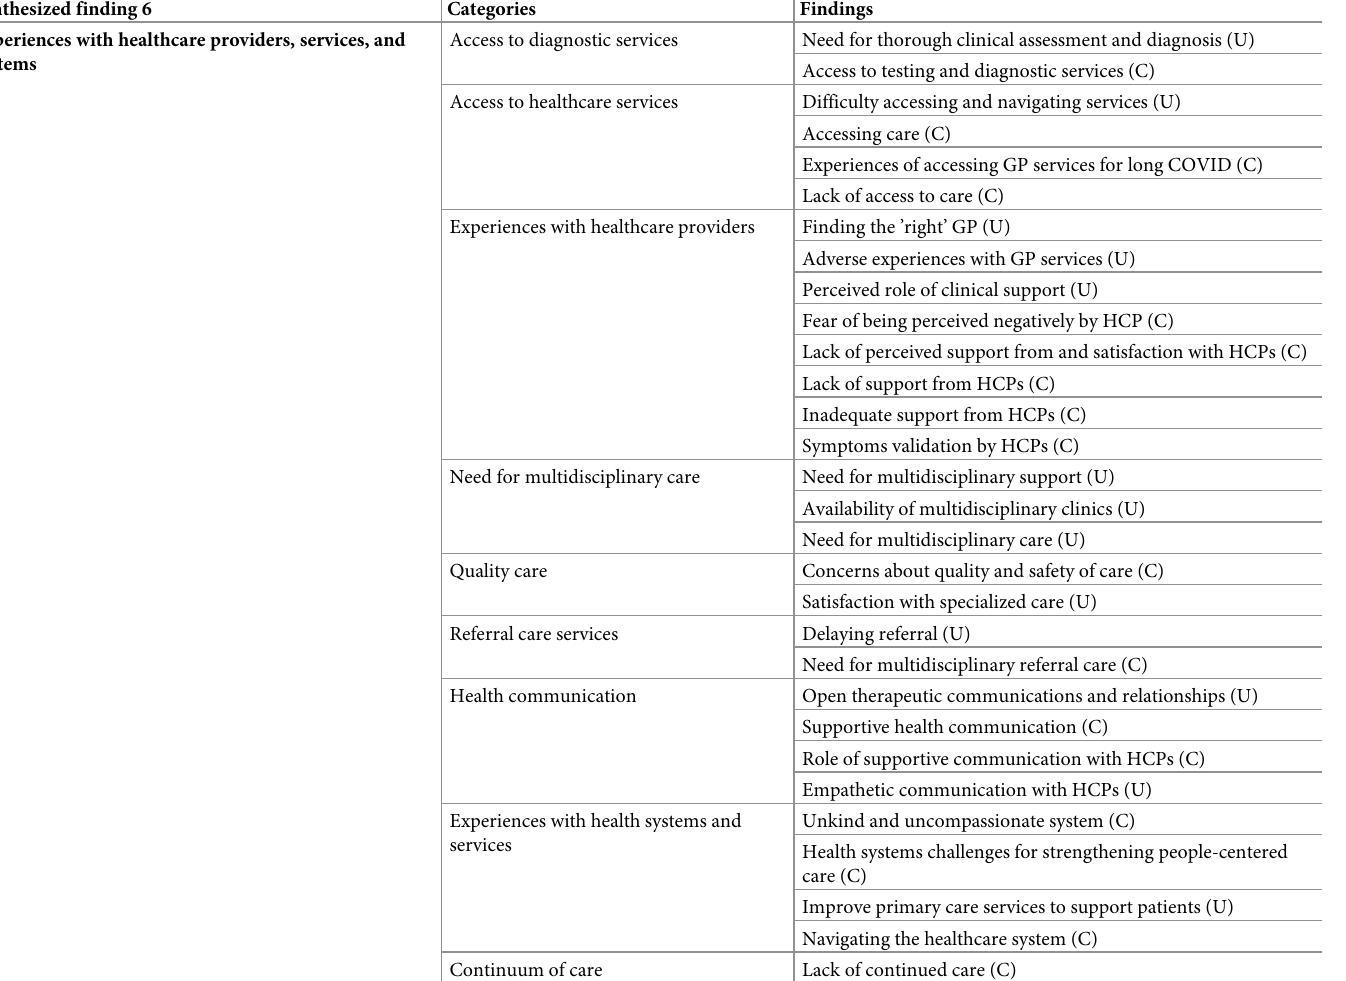
Table 8. Findings and categories within synthesized finding